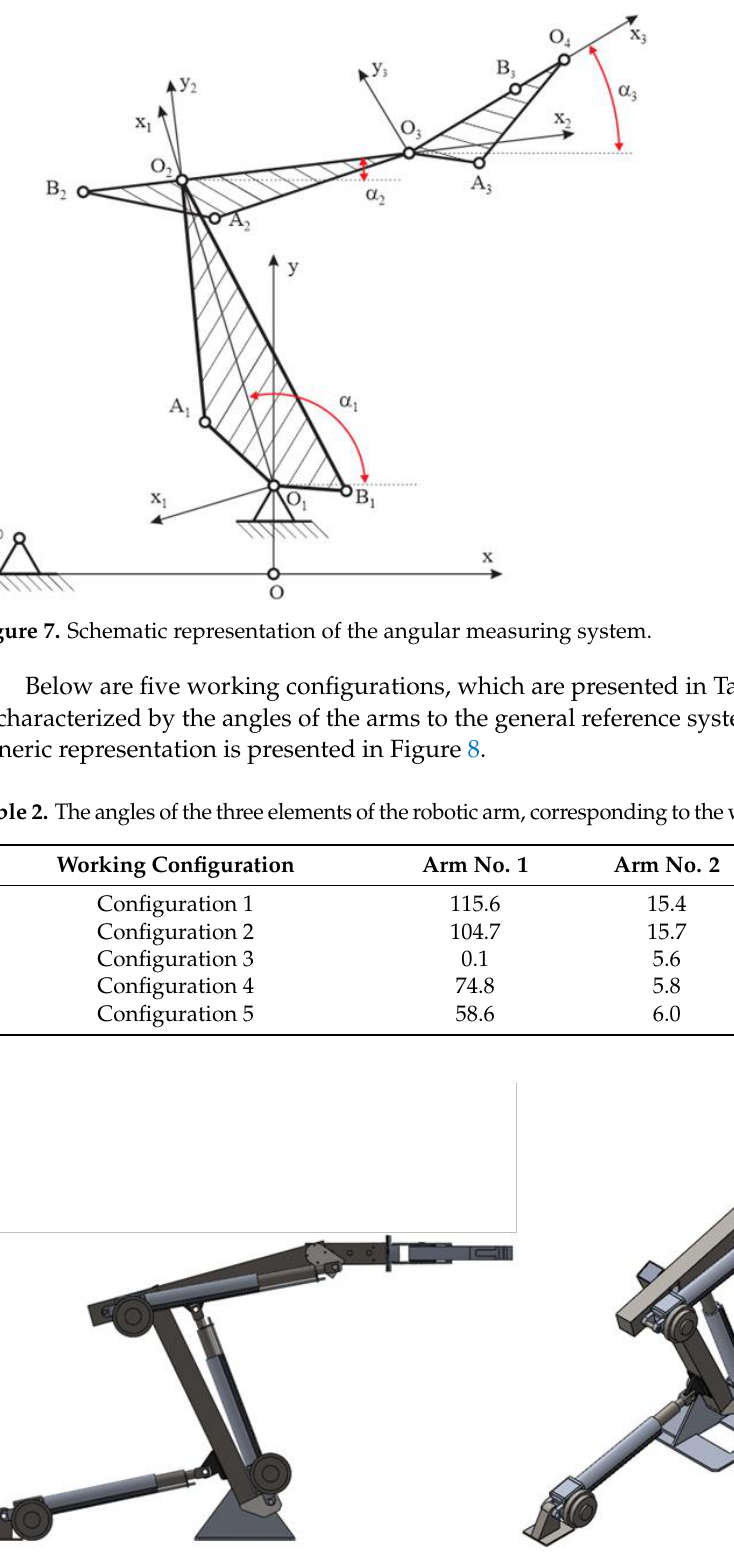
Figure 8. Three-dimensional representation of the robotic arm, for which arm 3 was determined to remain in a horizontal position. These inclinations of arms 1 and 2 while keeping arm 3 in a horizontal position are intended to allow the measurement of the vertical displacements of the effector element, measured by means of a laser sensor. The angular orientation of the different working configurations can be found in Table 2. Table 2. The angles of the three elements of the robotic arm, corresponding to the working config- urations.